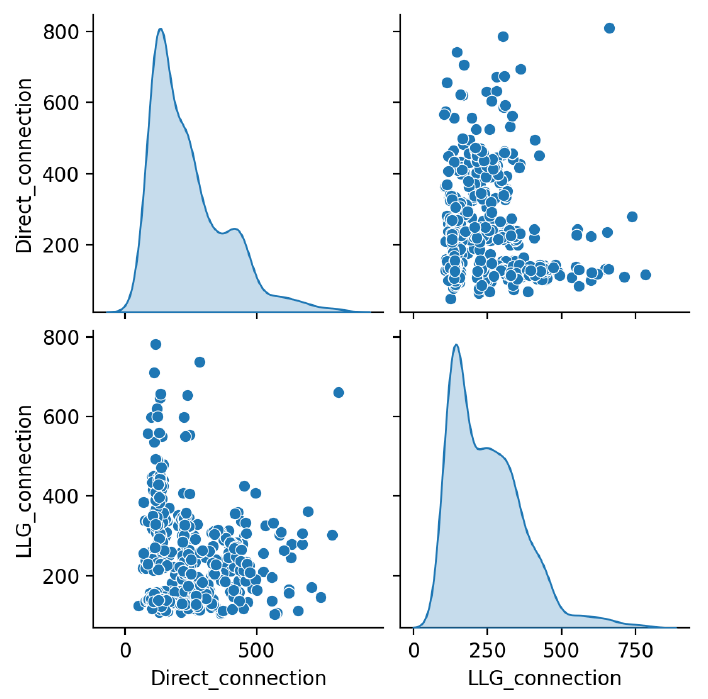
Figure 12. Direct_connection and LLG_connection scatter plots